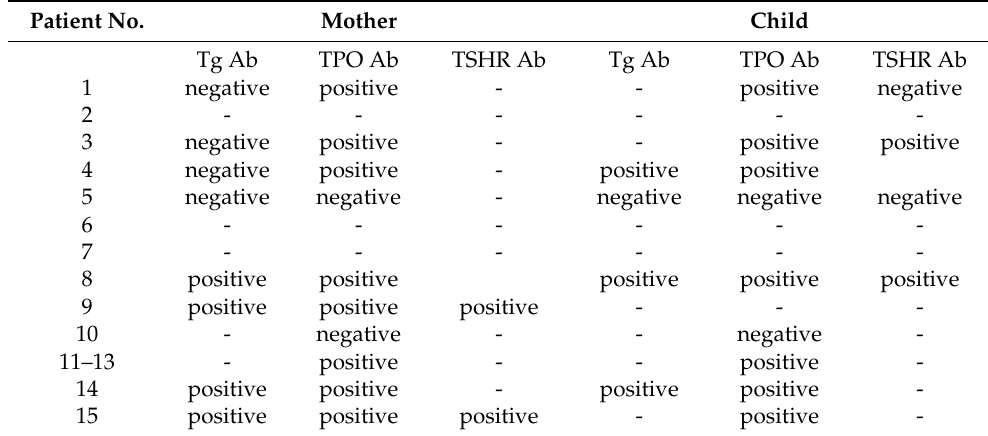
Table 3. Thyroid autoantibodies in the neonatal period in children with tCH and their mothers. Patient